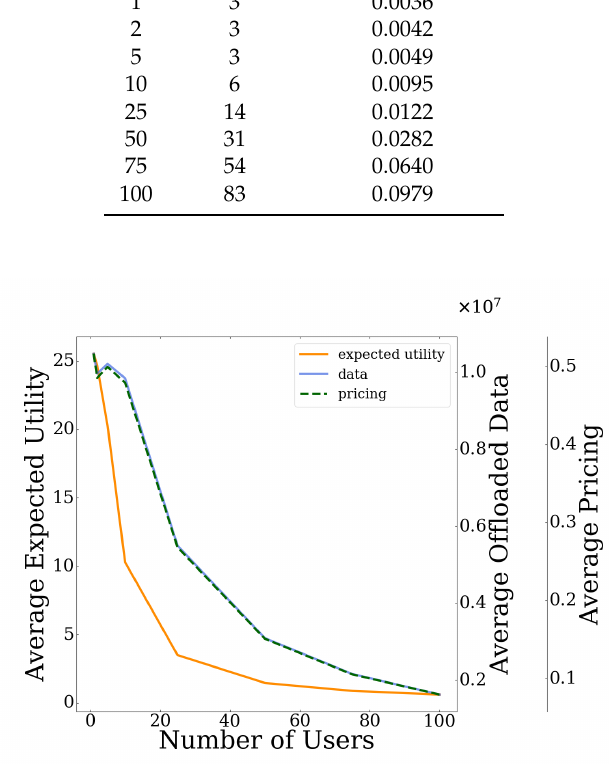
Figure 10. Users’ average expected utility, users’ average offloaded data and pricing at the PNE vs. number of users on the